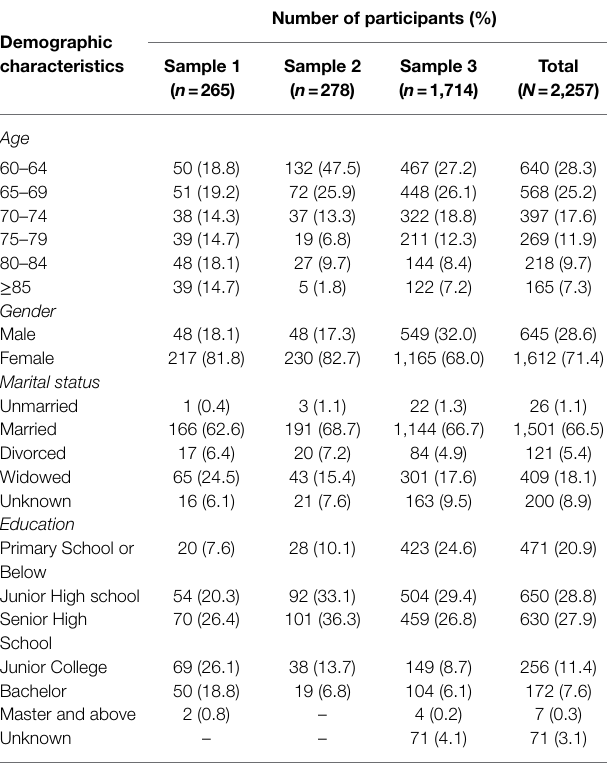
TABLE 1 | Demographic characteristics of the study